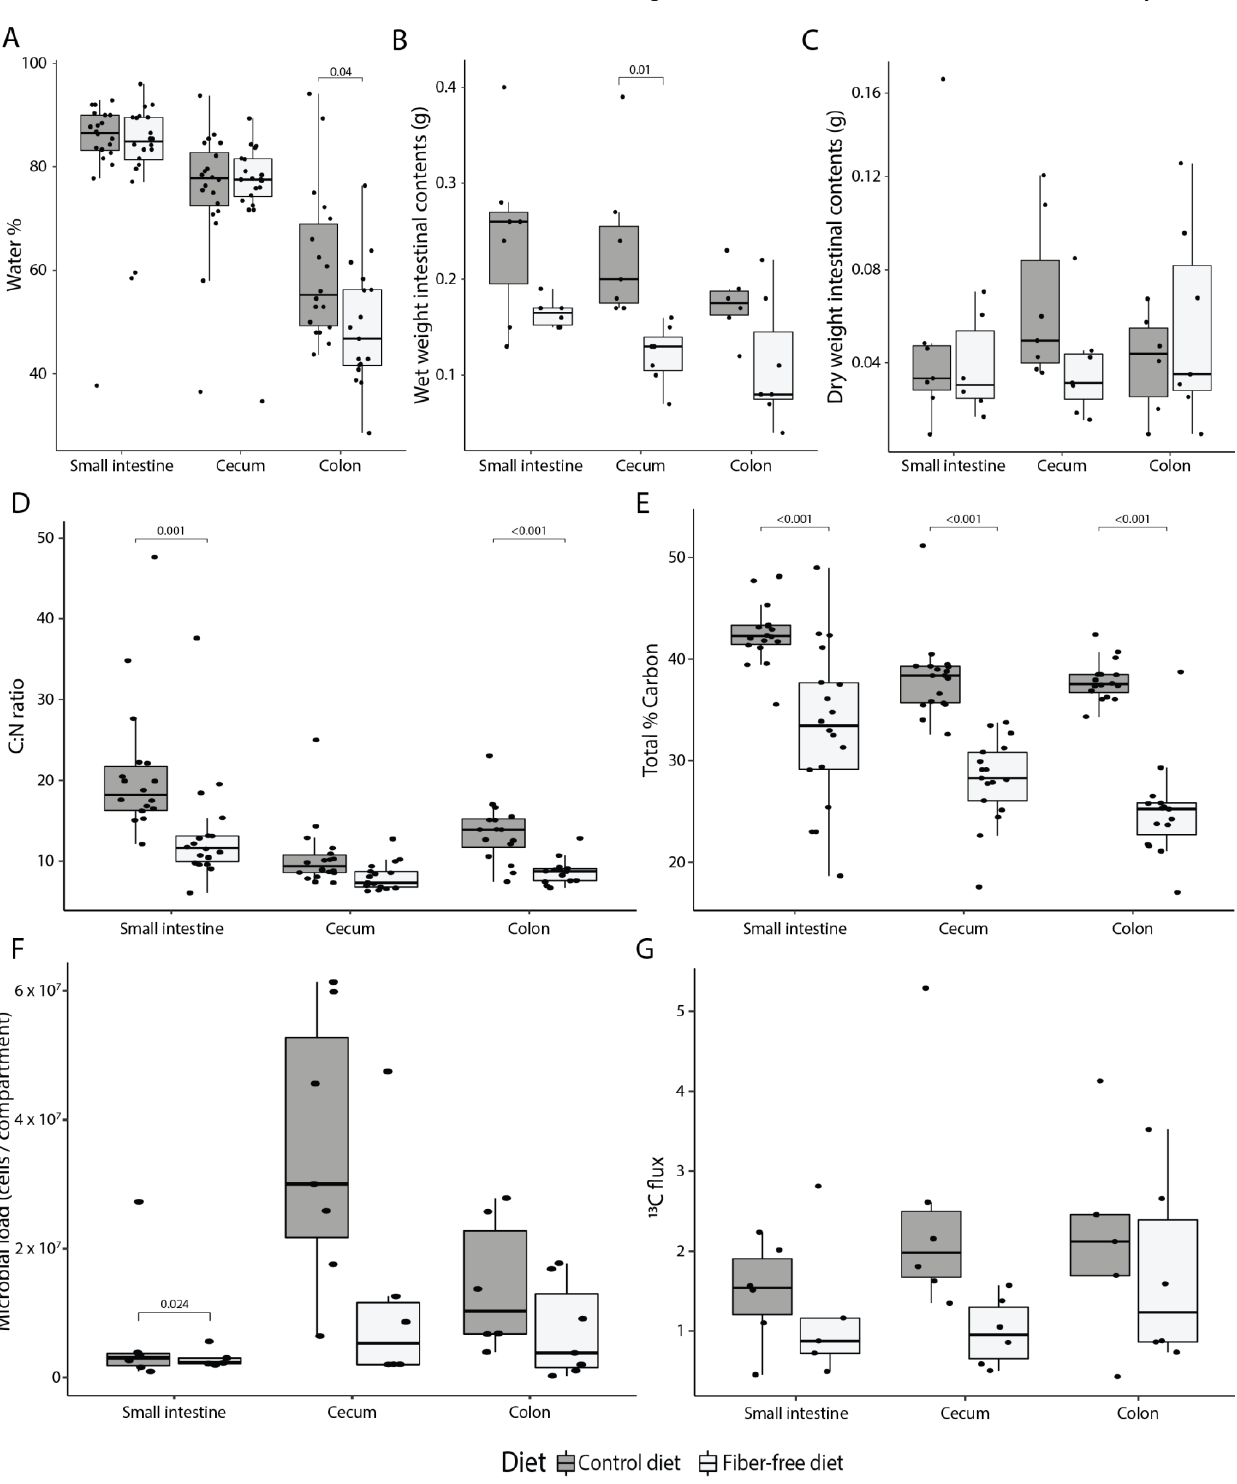
Figure 2. Effect of fiber deficiency on luminal contents and mucus secretion. ( A ) Percentage of water in the intestinal content decreases along the intestinal tract (ANOVA, p < 0.001), and is significantly less in the colon of mice fed a fiber-free diet (FFD) compared to a control diet (CD). ( B ) Fiber deficiency reduces the wet weight of intestinal contents (ANOVA, p < 0.001). ( C ) Dry weight of intestinal contents is not affected by diet. ( D ) Fiber deficiency significantly reduces the carbon to nitrogen ratio (ANOVA, p < 0.001). ( E ) Total percent of carbon in the lumen is significantly decreased with